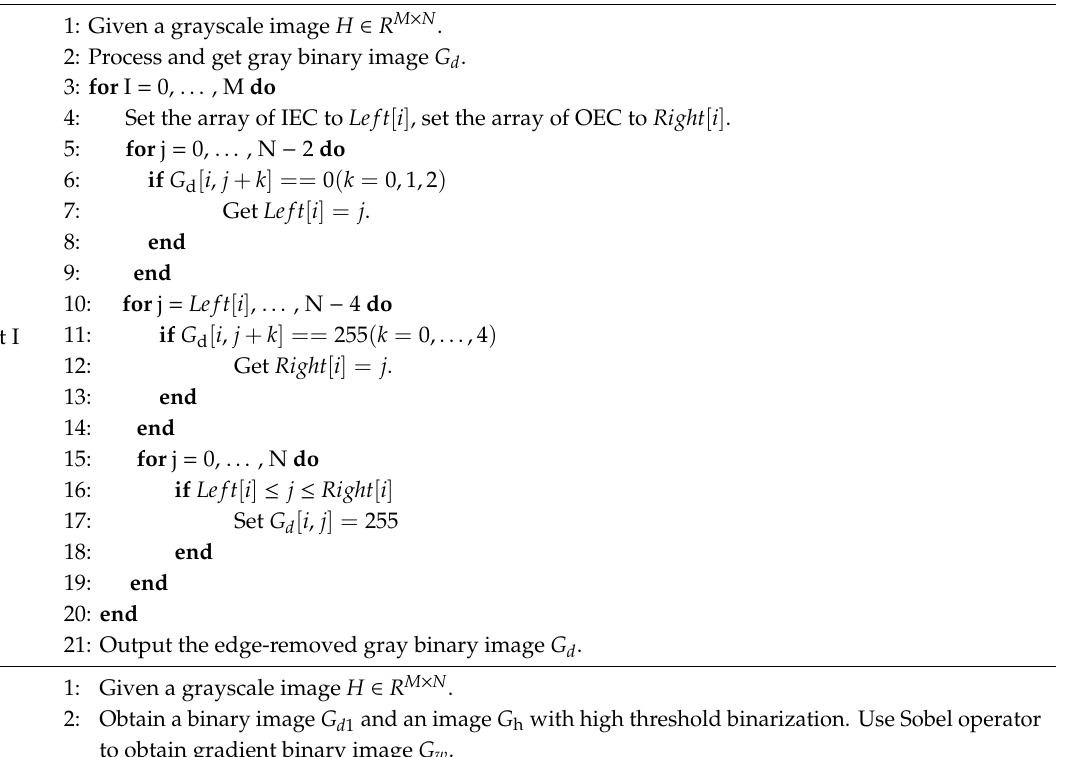
Algorithm 2 Image Edge Removal